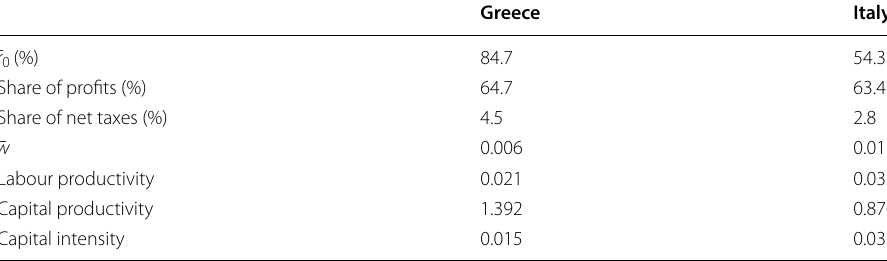
Table 5 The initial values of the actual average profit rates and their